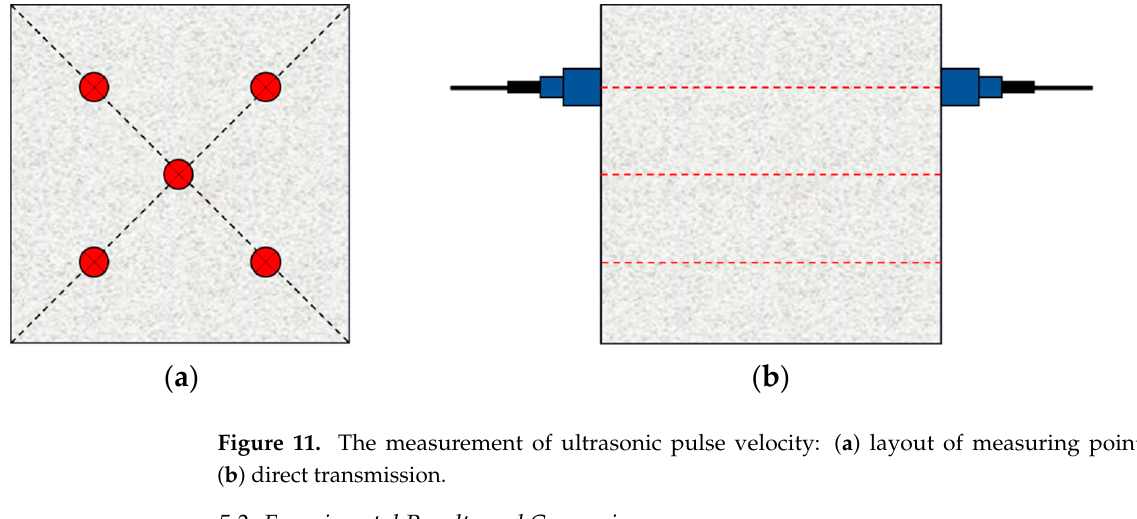
Figure 11. The measurement of ultrasonic pulse velocity: ( a ) layout of measuring points and ( b ) direct transmission. 5.2. Experimental Results and Comparison The testing results of the UPV are shown in Figure 12.